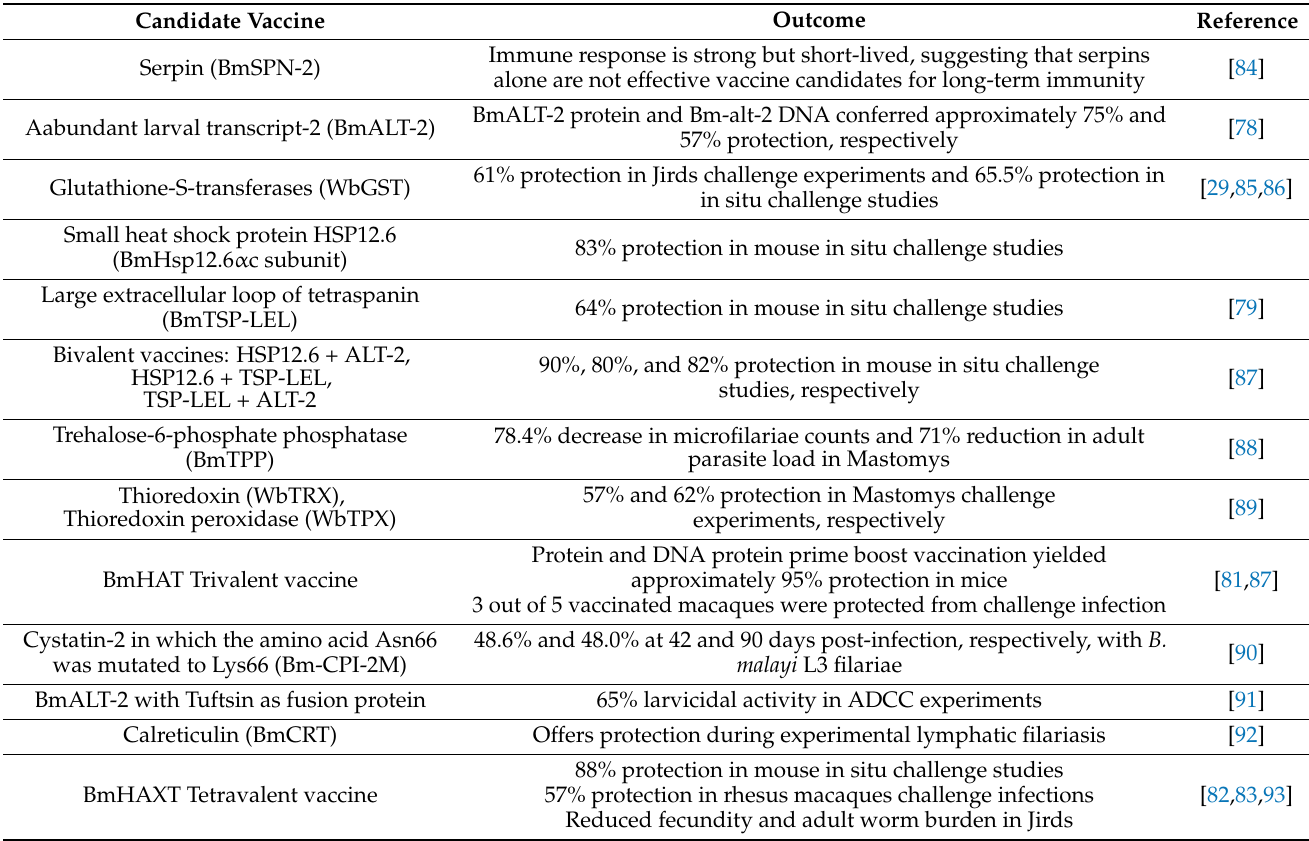
Table 1. Filarial immune-regulatory proteins that have been evaluated as vaccine